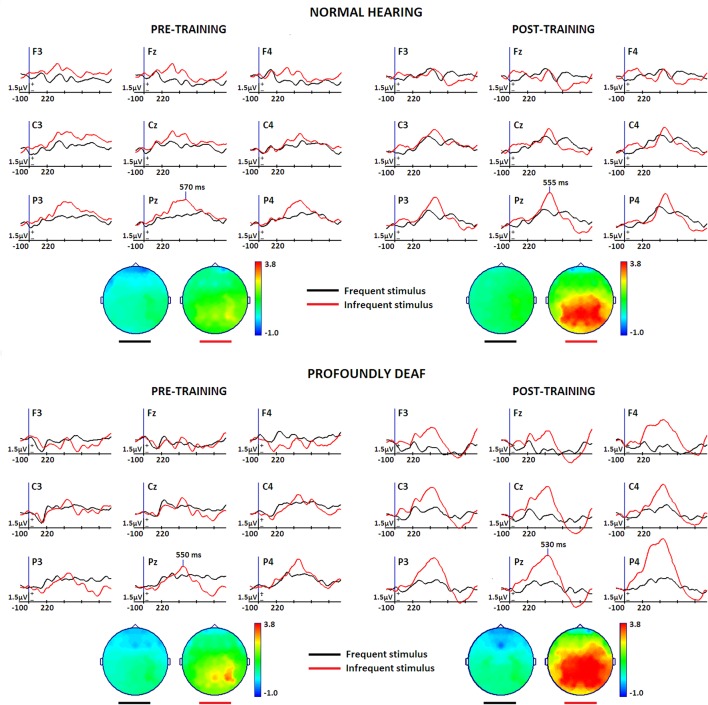
Midline and vicinity group grand-mean ERP waveforms for the differences between rare target (red) and frequent non-target (black) conditions while performing a vibrotactile tone-frequency discrimination oddball task, before and after a short training period in vibrotactile recognition. The normal-hearing group (n = 12) is represented at the top of the Figure, and deaf participants (n = 12) at the bottom. Topographic maps show the voltage distribution at maximum peak latency. A pre-stimulus period of 100 ms was used for baseline correction. Stimulus onset corresponds to the initial time instant in the Figure.